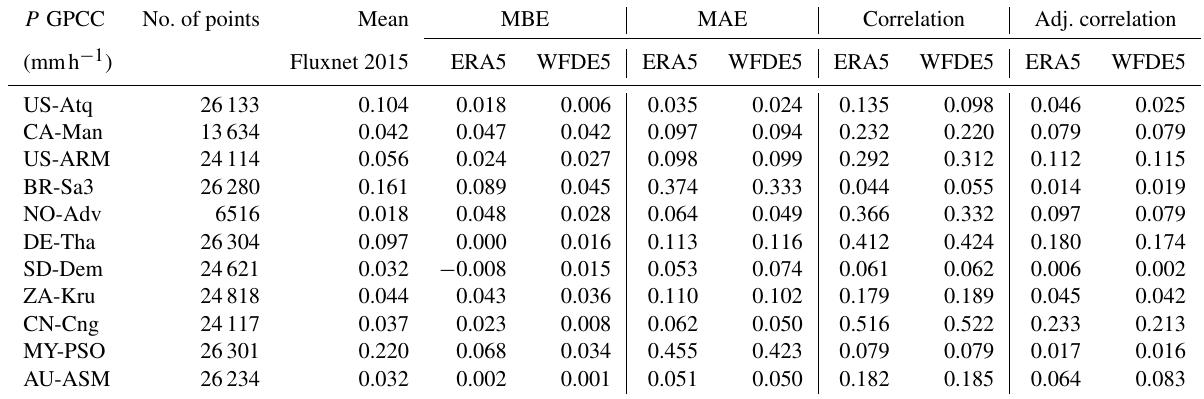
Table A8. Precipitation (Rainf + Snowf) metrics, corrected using GPCC totals, for each FLUXNET2015 site: ERA5 versus FN2015 and WFDE5 versus FN2015 at hourly time